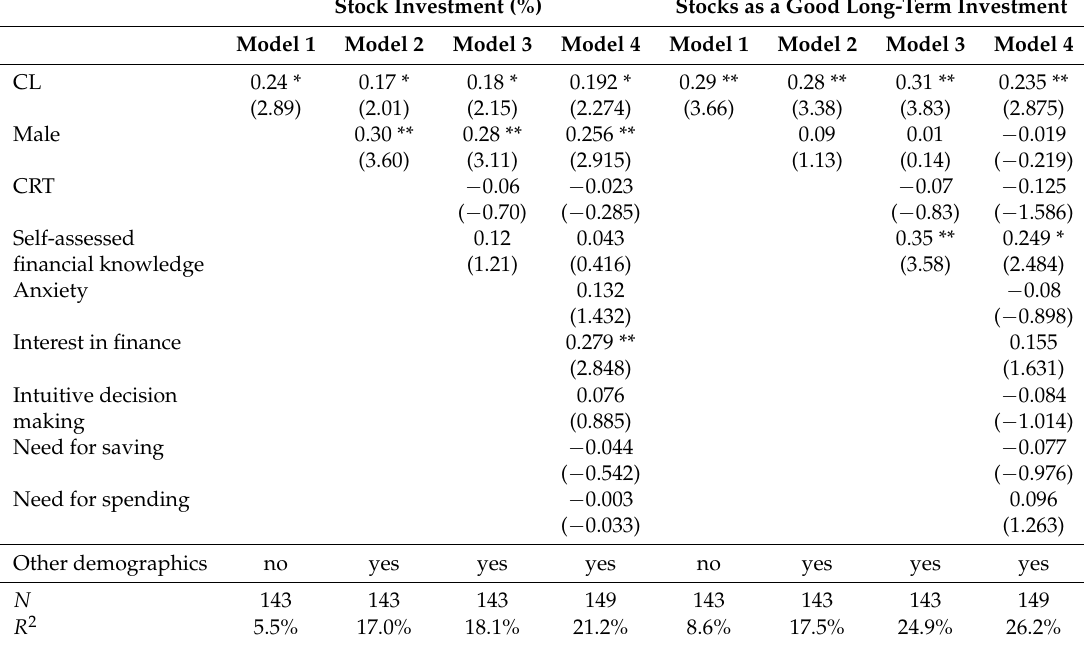
Table 11. CL can explain stock market investment decisions and general attitudes towards long-term returns. Self-assessed financial knowledge has an explanatory power for the latter, while gender affects only the investment decisions. The effect is robust when controlling for other demographics and for attitudes towards